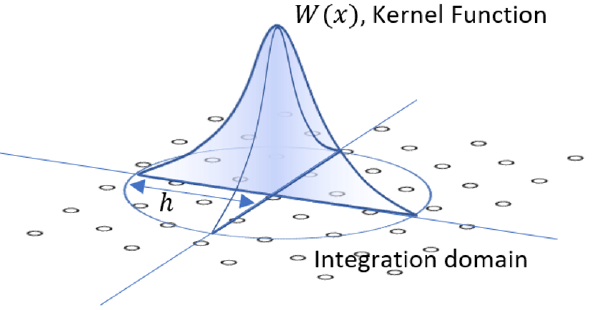
Figure 2. Example of a kernel function used as integration domain for mathematical